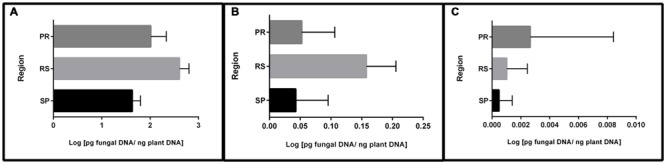
Mean DNA concentration of trichothecene genotypes in wheat grains from different regions of Brazil. (A) 15-ADON; (B) NIV; (C) 3-ADON. Bars indicate the standard deviation.